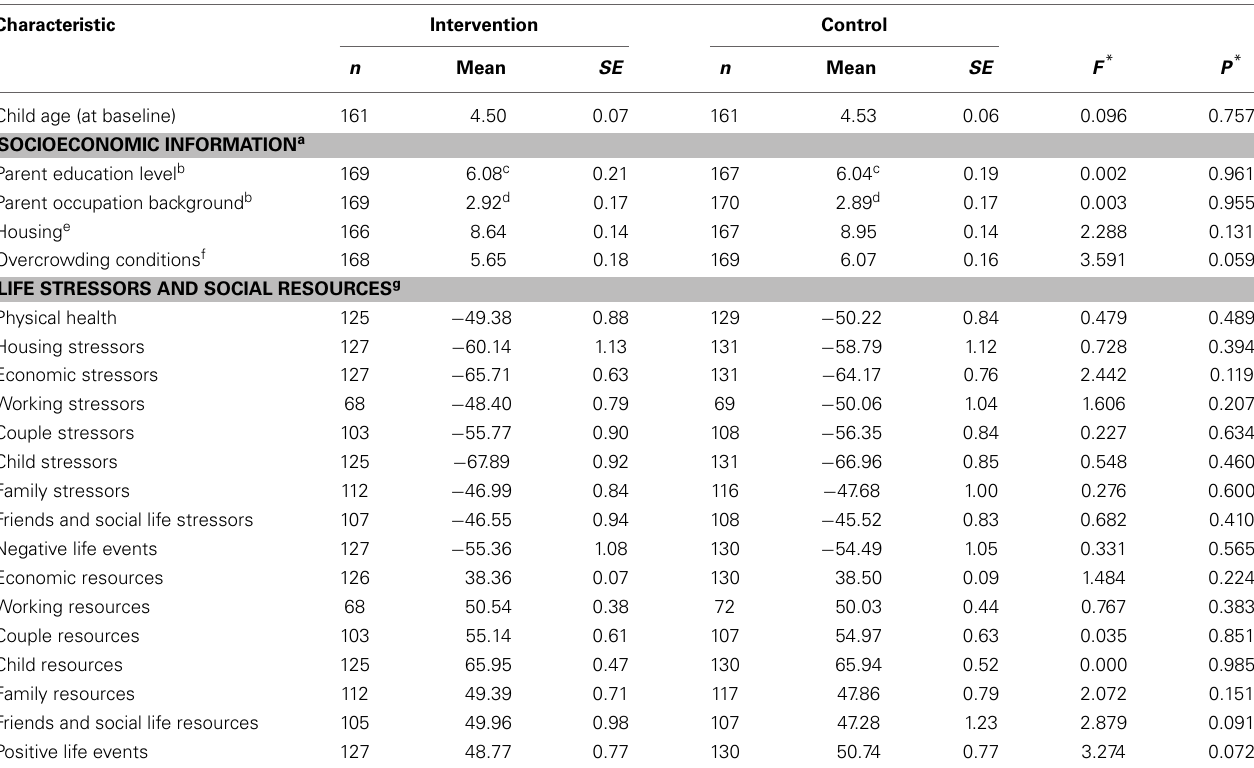
Table 2 | Sociodemographic information of the SIP sample by group (continuous variables).